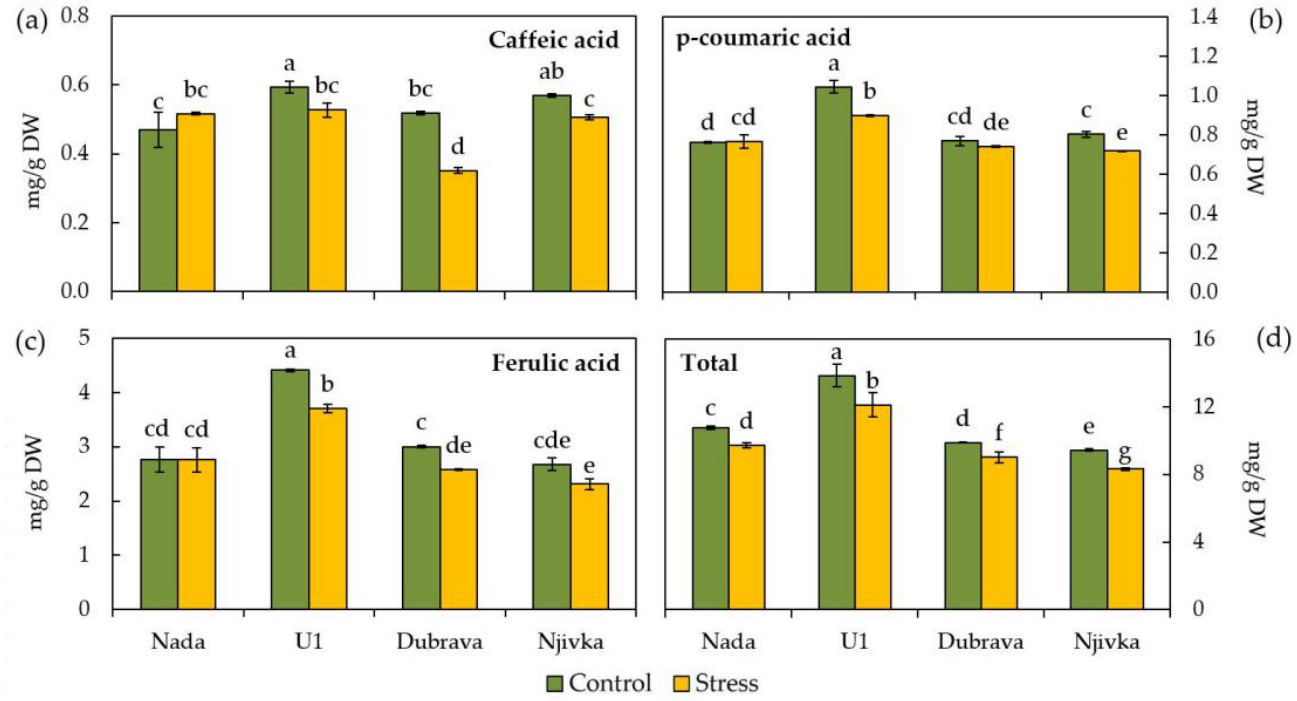
Figure 4. Caffeic acid ( a ), p-coumaric acid ( b ), ferulic acid ( c ), and total phenolic content ( d ) in control and drought stressed flag leaves of wheat cultivars. Bars represent mean values ± SE. Different letters indicate a significant difference among treatments and cultivars at p < 0.05 according to LSD test.